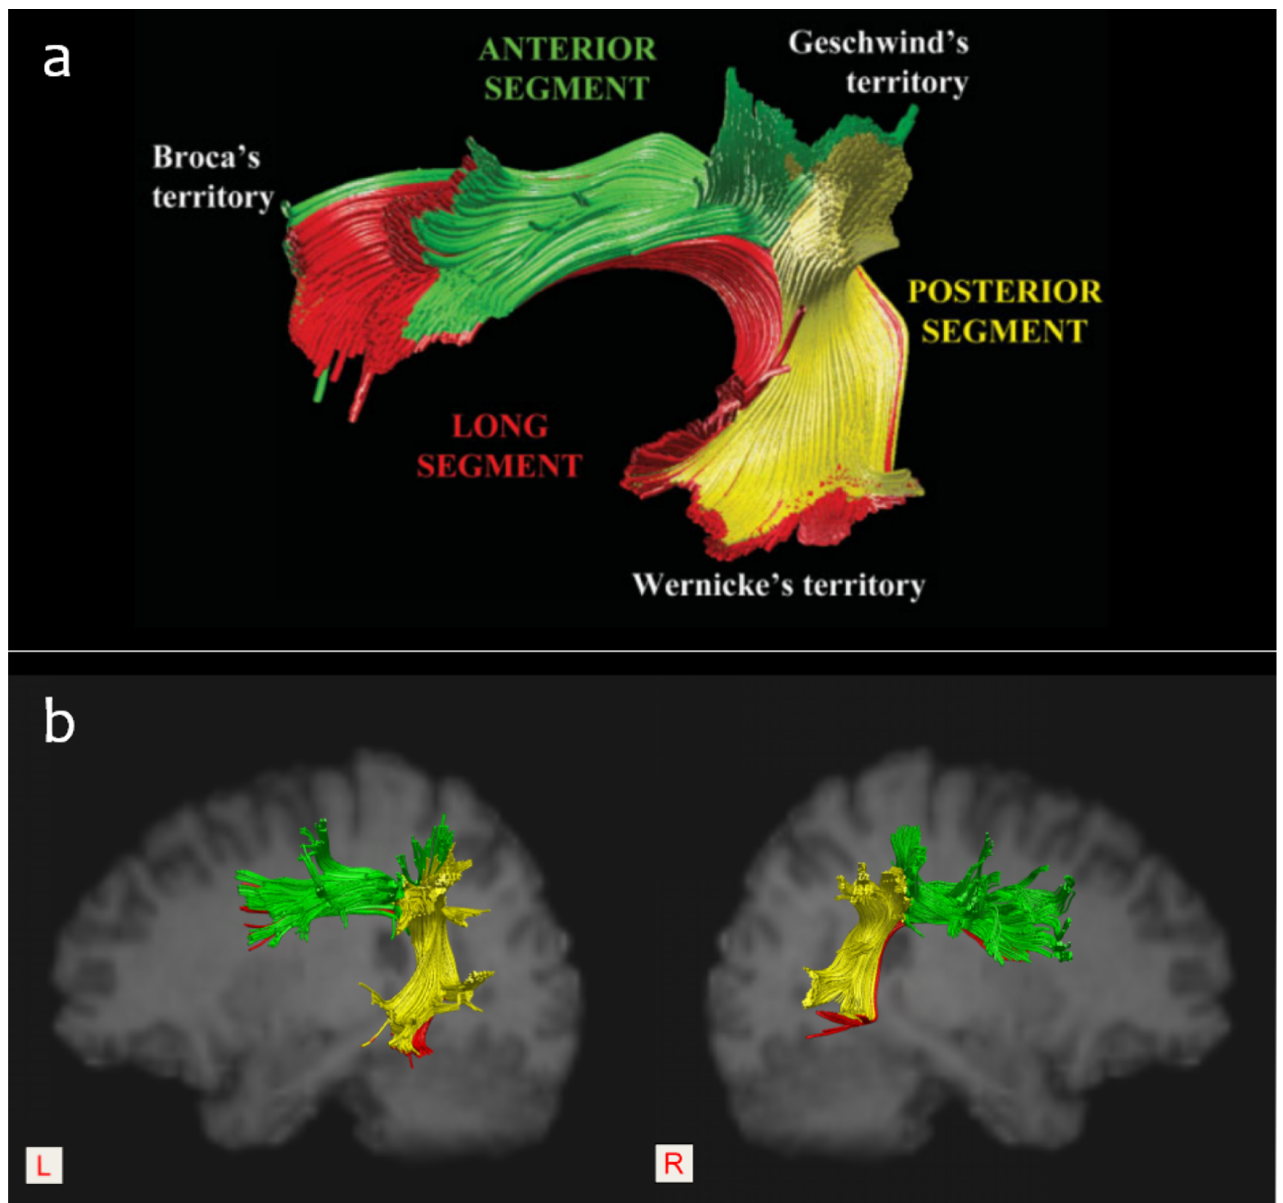
Figure 4. ( a ): The three-segment model of the AF outlined by Catani et al. (2005) [21], permission obtained. ( b ): A sample of the intact bilateral AF segments reconstructed according to the three-ROI approach.